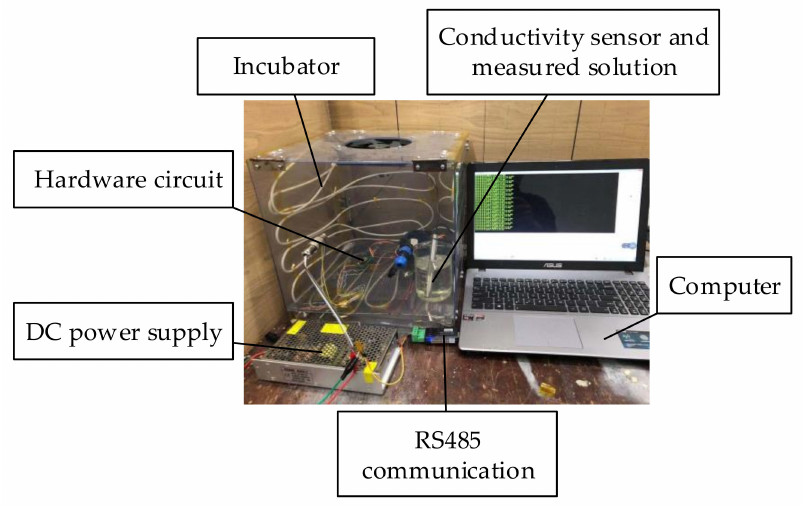
Figure 19. Experimental diagram of high temperature resistance of system